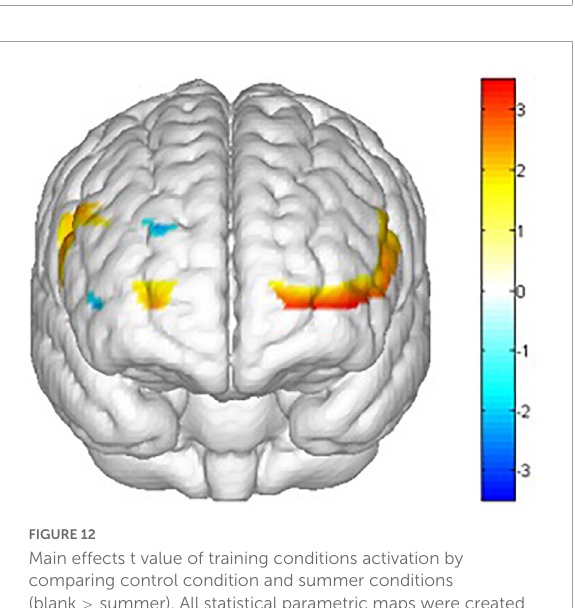
FIGURE11 Mapping of the main effects F value of response inhibition activation. The activation degree ( β ) of the nogo task was higher than that of the go task in the rvPFC, rdPFC, lvPFC, and ldPFC. All statistical parametric maps were created with a threshold of p < 0.05.